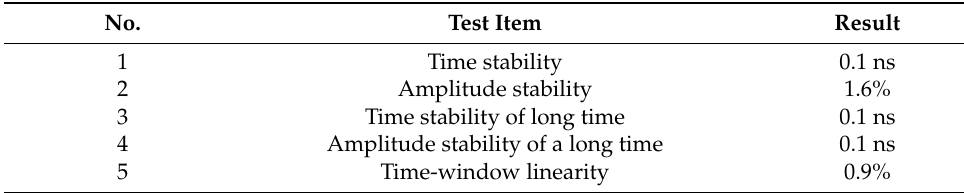
Table 1. The test project results of the GPR antenna stability test.